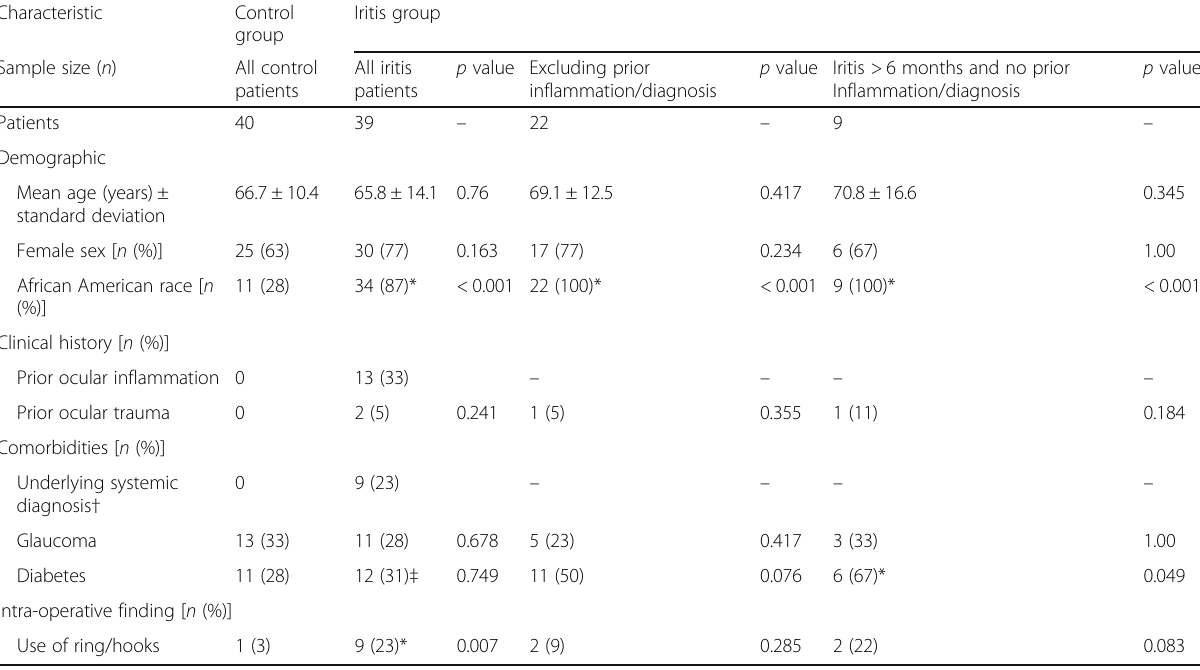
Table 1 Comparison of characteristics between patients with persistent post-operative iritis versus control group with associated p values